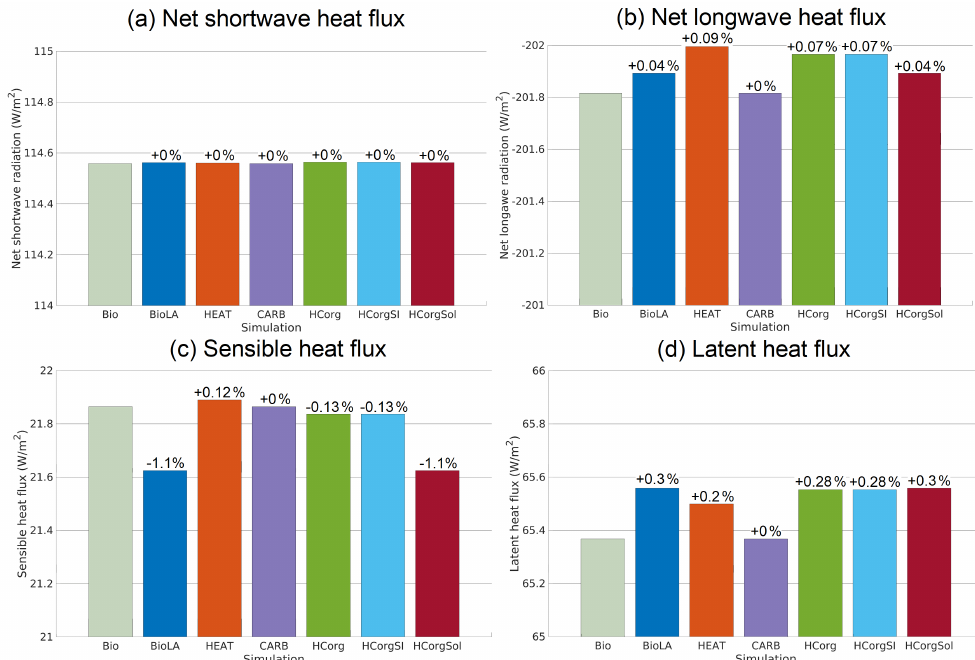
Figure 5. Global average of the different air–sea heat fluxes (Wm − 2 ) for the seven simulations. (a) Net shortwave radiation at the top of the atmosphere. (b) Net re-emitted longwave radiation. The net longwave radiation is negative, because it is dominated by the outgoing longwave radiation. (c) Sensible heat flux. (d) Latent heat flux. The color coding between the panels remains the same. The percentages represent the relative changes compared to